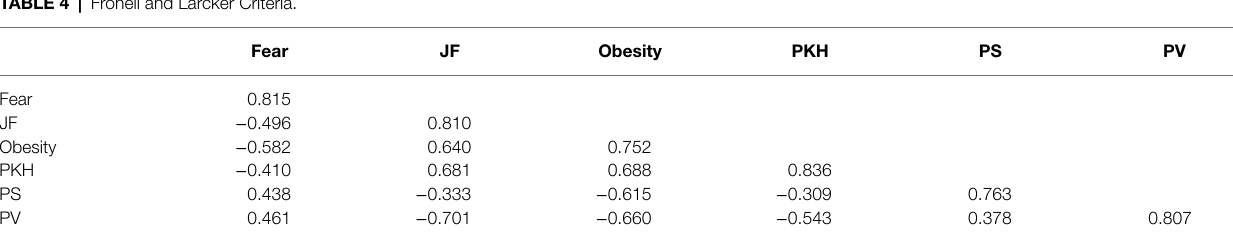
TABLE 4 | Fronell and Larcker